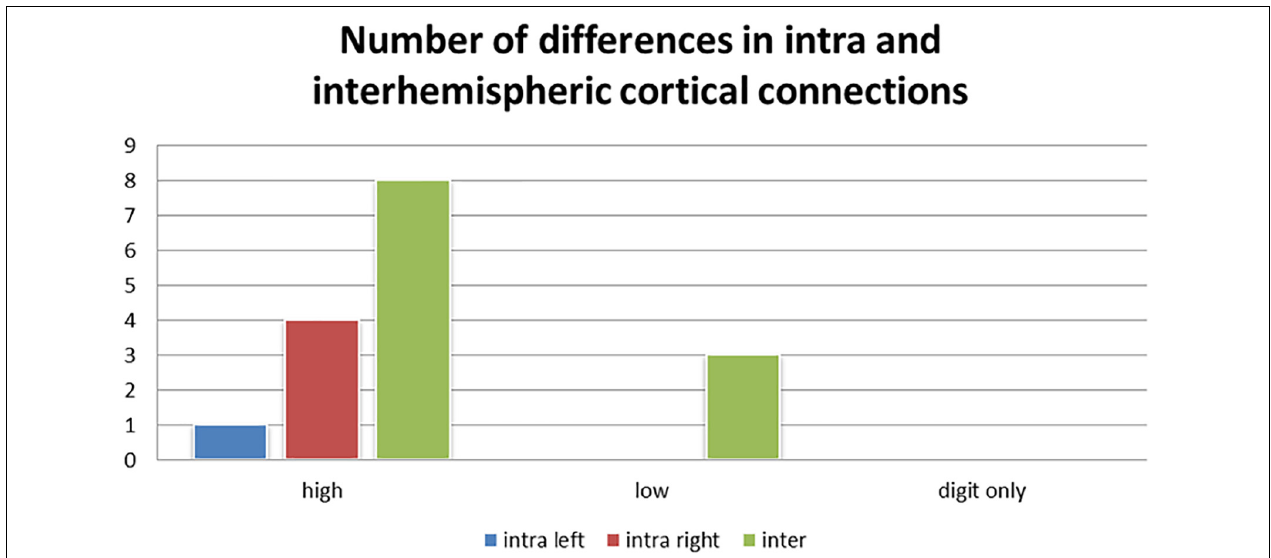
FIGURE 5 | Number of differences in neural connections: Intra-right hemisphere, intra-left hemisphere and inter-hemispheric cortical differences in tasks of high working memory load (5D versus 5T), low working memory load (1D versus 1T), and digits only (5D versus 1D).